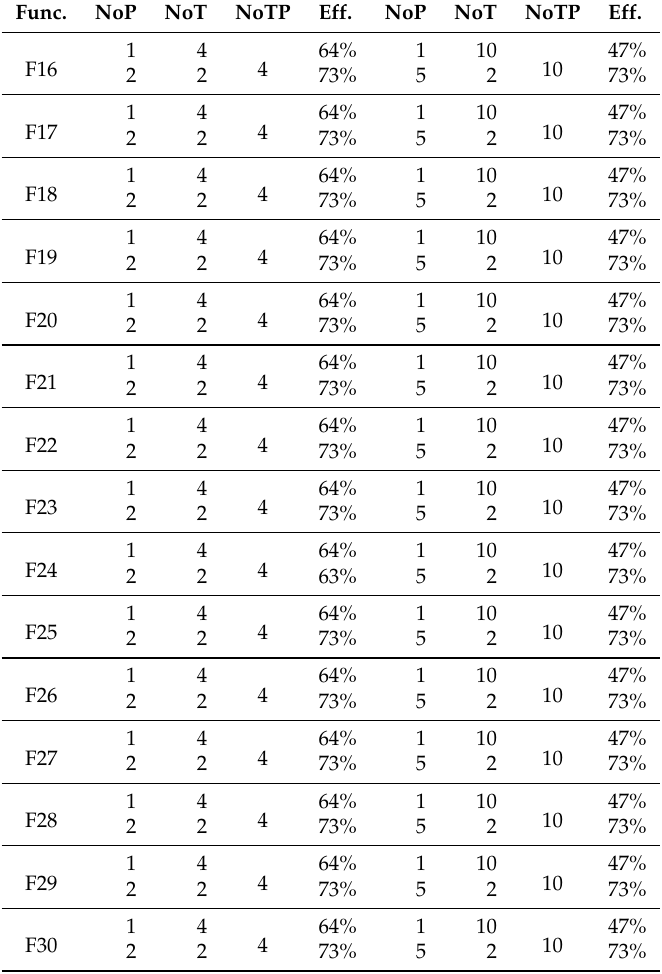
Table 5. Efficiencies for hybrid MPI/OpenMP parallel algorithm, Runs = 30, Population size = 240, Iterations = 1000.